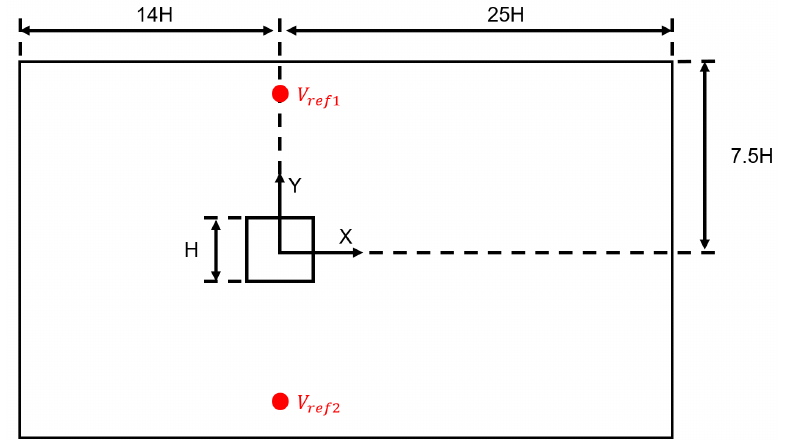
Figure 1. Overall channel dimensions (not to